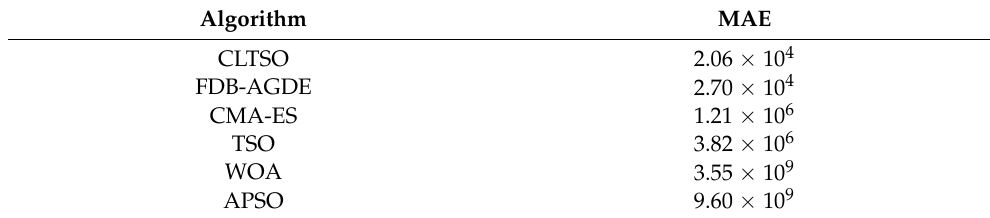
Table 9. MAE ranking results of each